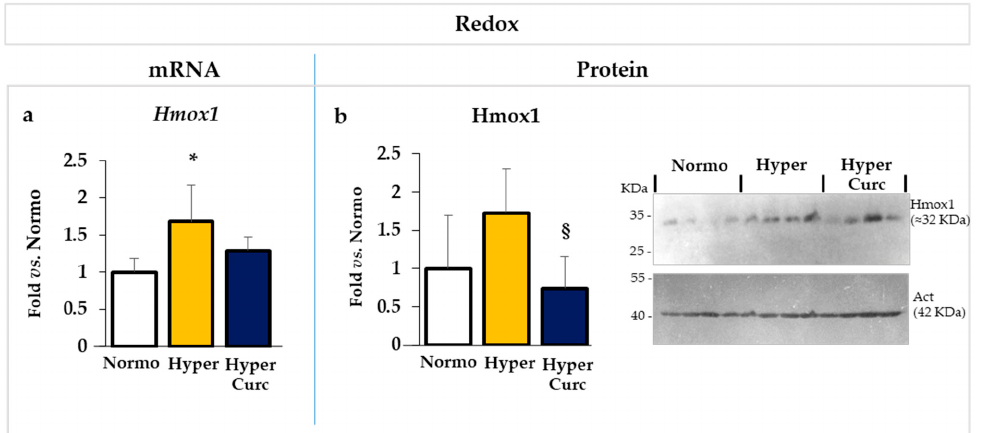
Figure 7. Curc prevents the increase in the redox stress in the Hyper Gunn rat. The effect of Curc on the mRNA ( a ) and protein ( b ) level of Hmox1 /Hmox1 (heme oxygenase 1), a redox sensor, was evaluated by RTqPCR and Western blot, respectively. With white bars—untreated normobilirubinemic (Normo) Gunn pups; yellow bars—untreated hyperbiliru- binemic rats (Hyper); blue bars—curcumin-treated hyperbilirubinemic pups (Hyper Curc). Data are in mean ± S.D. and expressed as fold vs. the Normo pups used as reference (=1). In each experimental group, ≥ 6 animals were studied. Statistical significance was evaluated by the one-way analysis of variance (ANOVA), followed by a Tukey–Kramer Multiple Comparisons Test when p -value < 0.05. Statistical significance: *: p < 0.05 vs. Normo pups. § p < 0.05 vs. Hyper